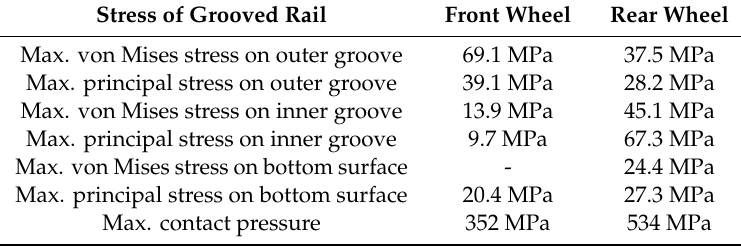
Table 5. Von Mises stress, maximum principal stress, and maximum contact pressure in the